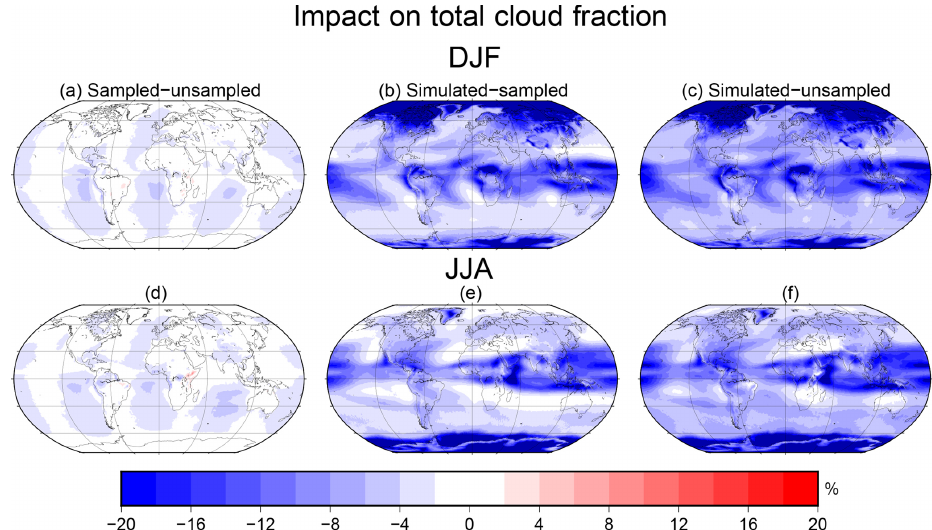
Figure 3. The simulated TCF minus the direct model output of TCF. Panels (a) and (d) show the impact of sampling the model to match the EOT of the satellites in a similar way as in Fig. 2 but this time for TCF and using the EOT shown in Fig. 1. It is the temporally sampled direct model output minus the direct model output (sampled–unsampled). Panels (b) and (e) show the simulated lack of sensitivity of the AVHRR sensor to optically very thin clouds ( τ c < 0 . 2). Specifically, they show the simulated Cloud_cci minus the temporally sampled direct model output (simulated–sampled). Panels (c) and (f) show the combined impact on these two effects, i.e., clouds removed and temporal sampling, compared to the direct model output (simulated–unsampled). The top row is valid for DJF, and the bottom is for JJA. The data cover the period